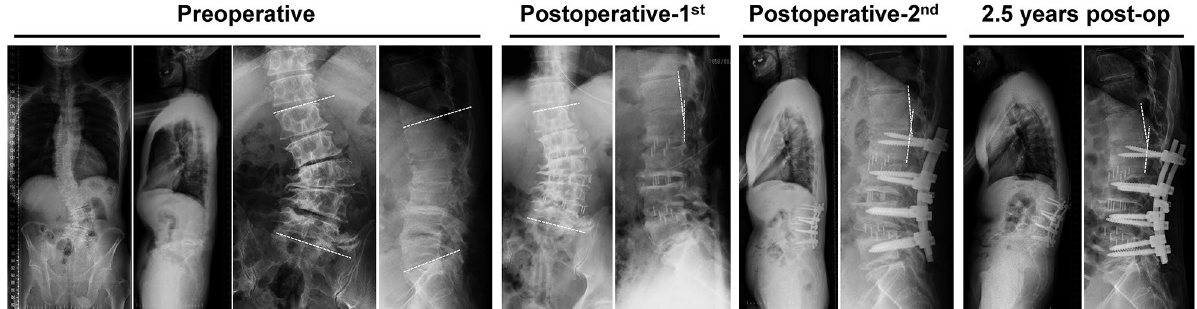
Figure 4. A 59-year-old male with low back pain and gait disturbance due to postural abnormalities. Preoperative radiological parameters showed poor global alignment with Cobb angle 32.2°, coronal decompensation 27.7 mm, LL 6.7°, L1–L2 angle −8.3°, and PI-LL 33.3°. Residual L1–L2 local kyphosis was apparent after the 1st and 2nd operations, and progressive proximal junctional kyphosis with severe low back pain appeared